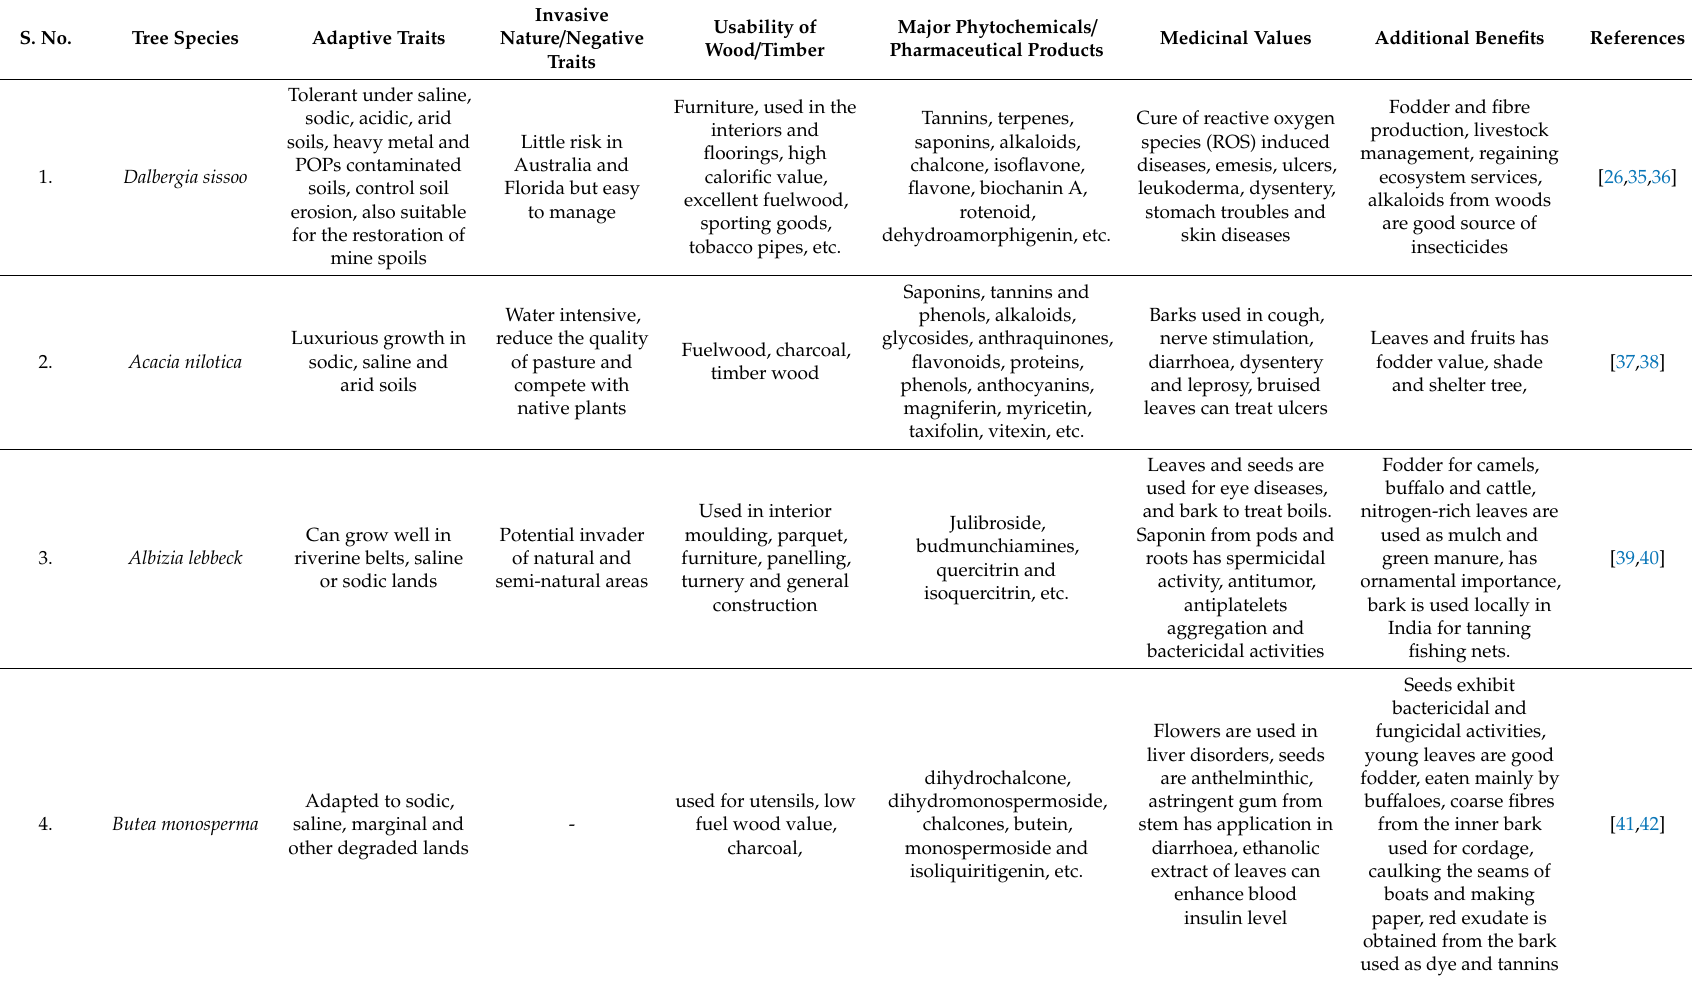
Table 1. Comparison of D. sissoo with other hard-wood, leguminous